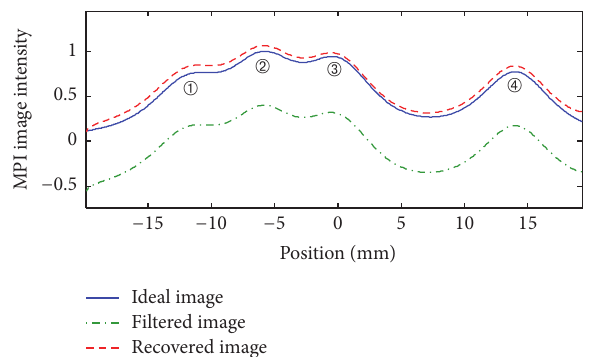
Figure 6: Case 1: filtered 1D 𝑥 -space MPI image and recovered image applying the proposed algorithm for a particle diameter of 30 nm.